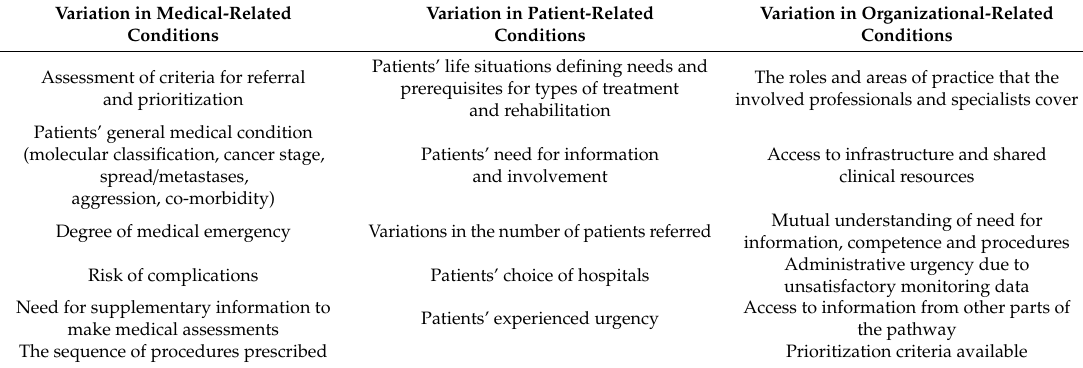
Table 3. More or less predictable variations creating uncertainties a ff ecting patient